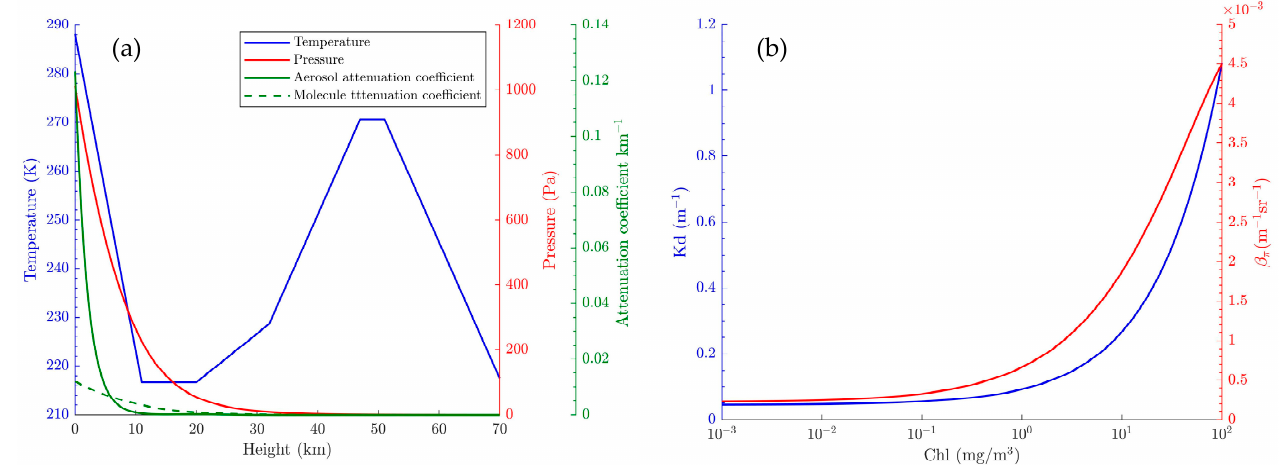
Figure 2. The temperature and pressure profiles used in the model and aerosol and molecular attenuation coefficient with the wavelength of 532 nm ( a ); K d and β π versus chlorophyll concentration with the wavelength of 532 nm ( b ).